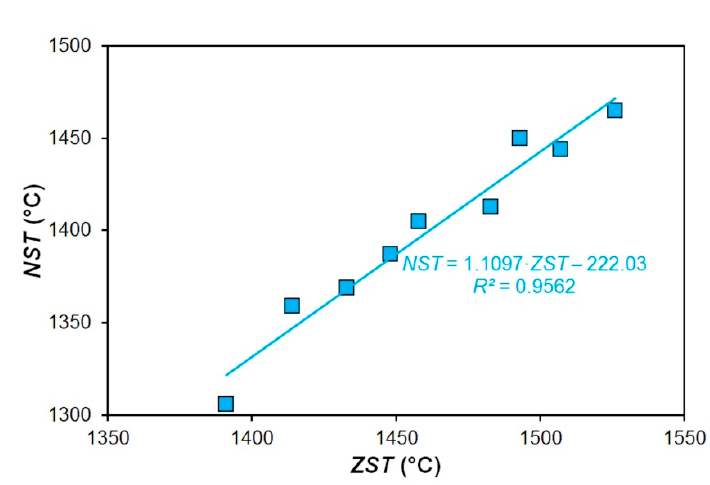
Figure 4. Dependence of the measured nil-strength temperature on the calculated zero strength temperature.